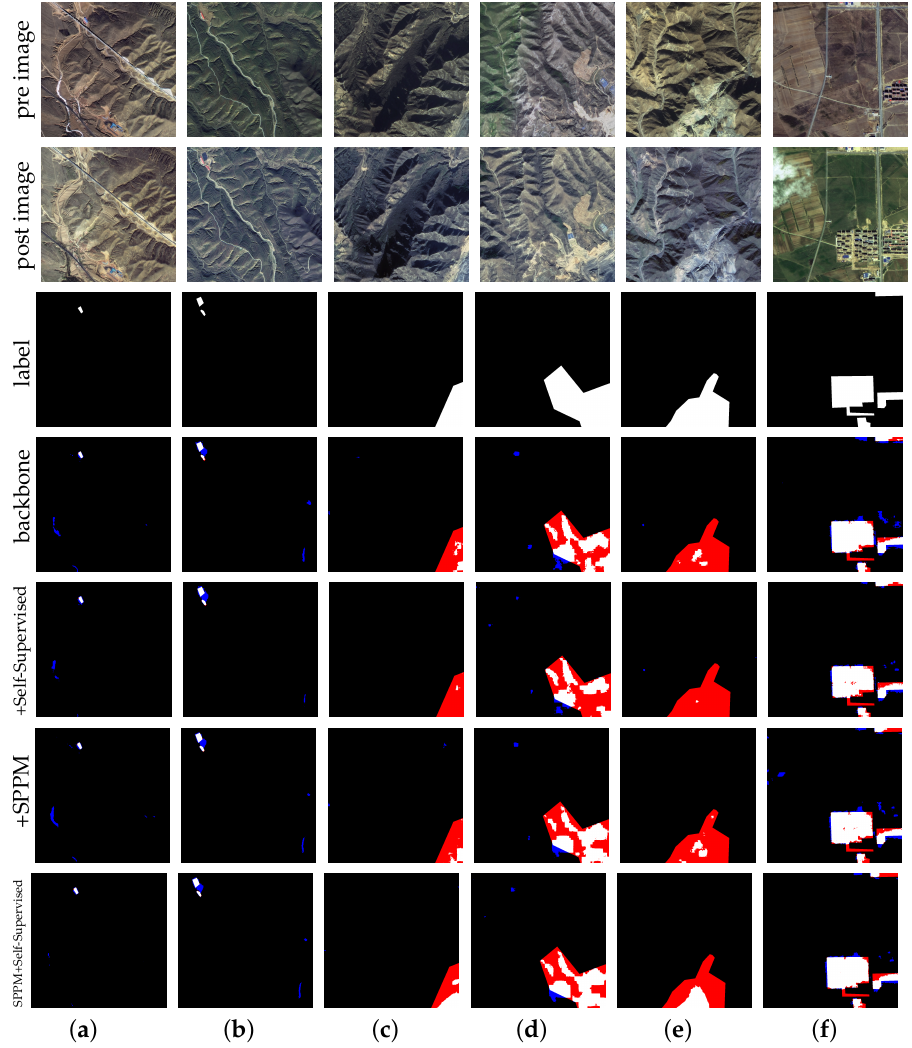
Figure 6. Six groups of images using different pre-trained models. ( a ) Buildings in Eco-redline areas. ( b ) Buildings in Eco-redline areas. ( c ) Mines in Eco-redline areas. ( d ) Mines in Eco-redline areas. ( e ) Mines in Eco-redline areas. ( f ) Buildings in rural